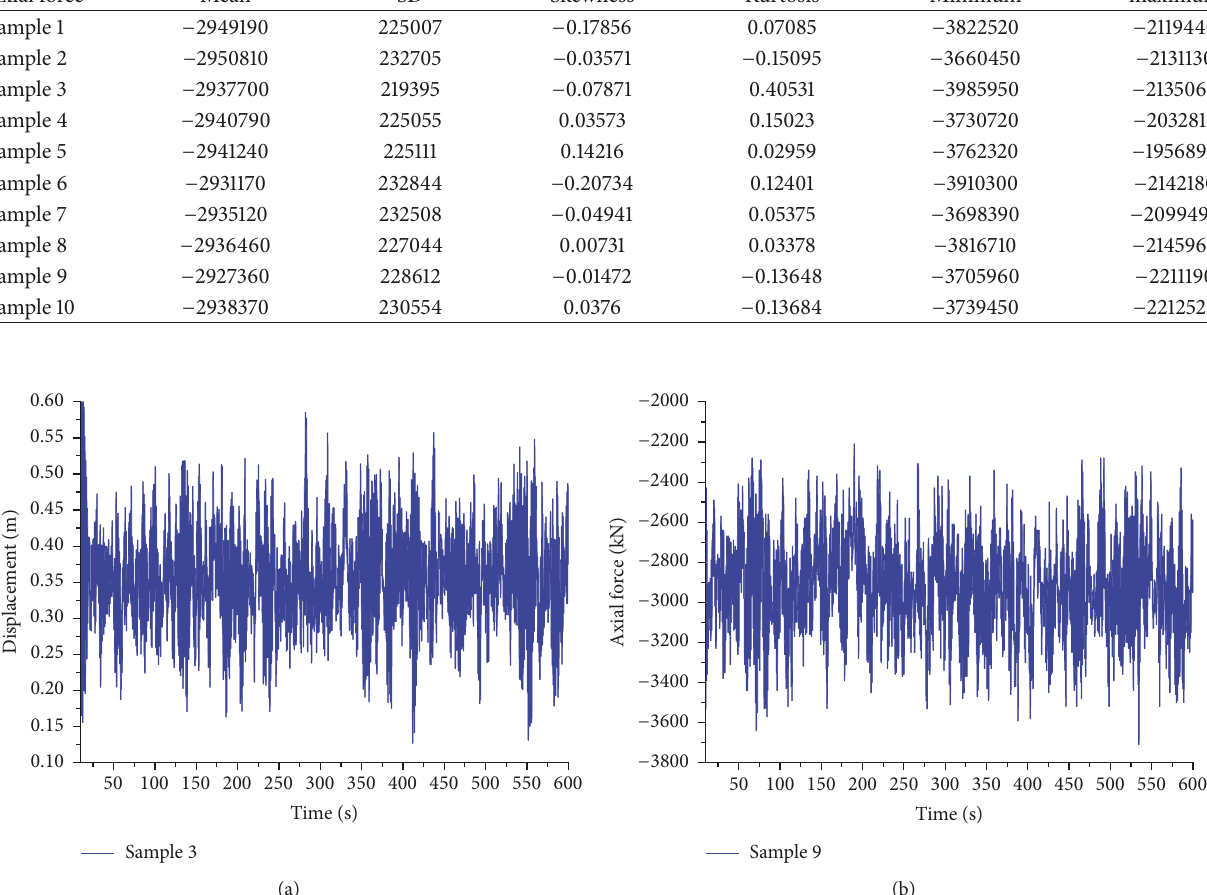
Figure 7: Time history curve of single high tower under wind field 1.